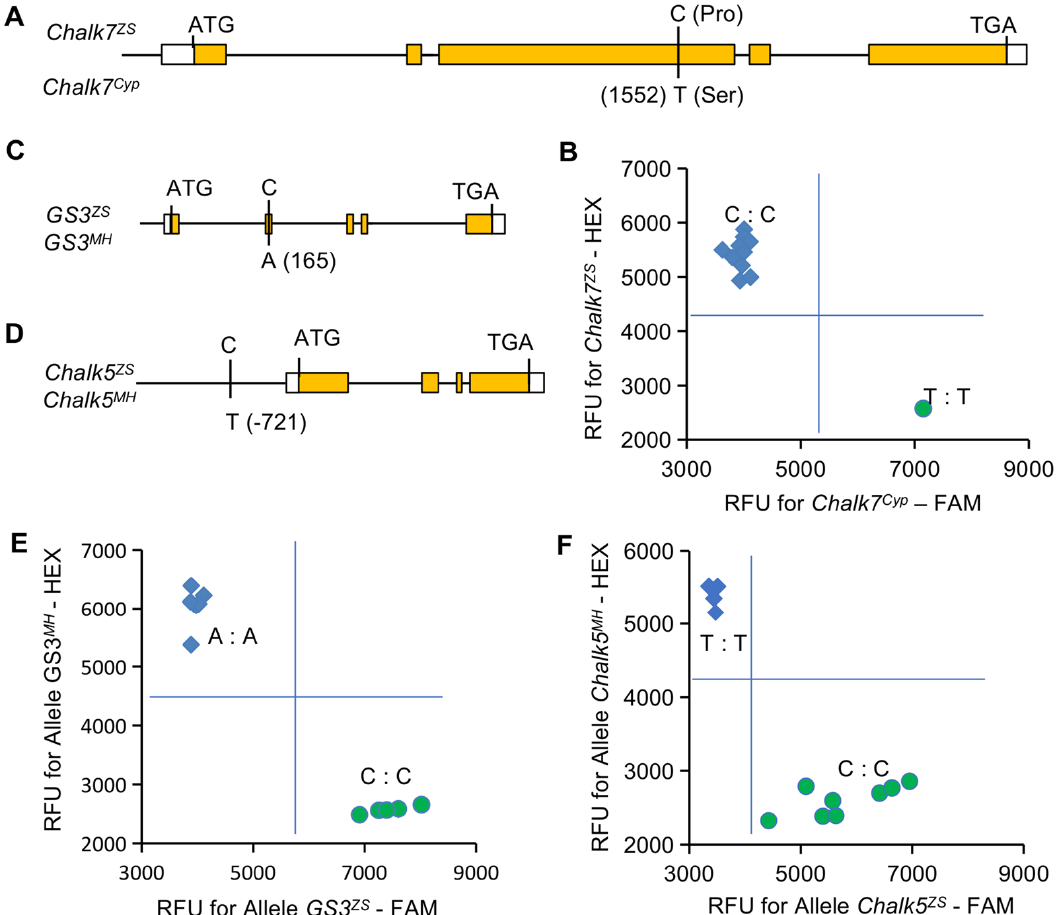
Figure 2. Development of the gene-specific markers for three grain quality genes. ( A , C , D ) Schematic diagram of the respective gene model showing the position of SNP for the marker development in Chalk7 ( A ), GS3 ( C ), and Chalk5 ( D ). ( B , E , F ) Genotyping of 12 rice accessions using the markers, K-Chalk7 ( B ), K-GS3 ( E ), and K-Chalk5 ( F ). RFU, relative fluorescence units. 2.3. Validation of Combined Effects of Corresponding Alleles at Three Loci in Rice